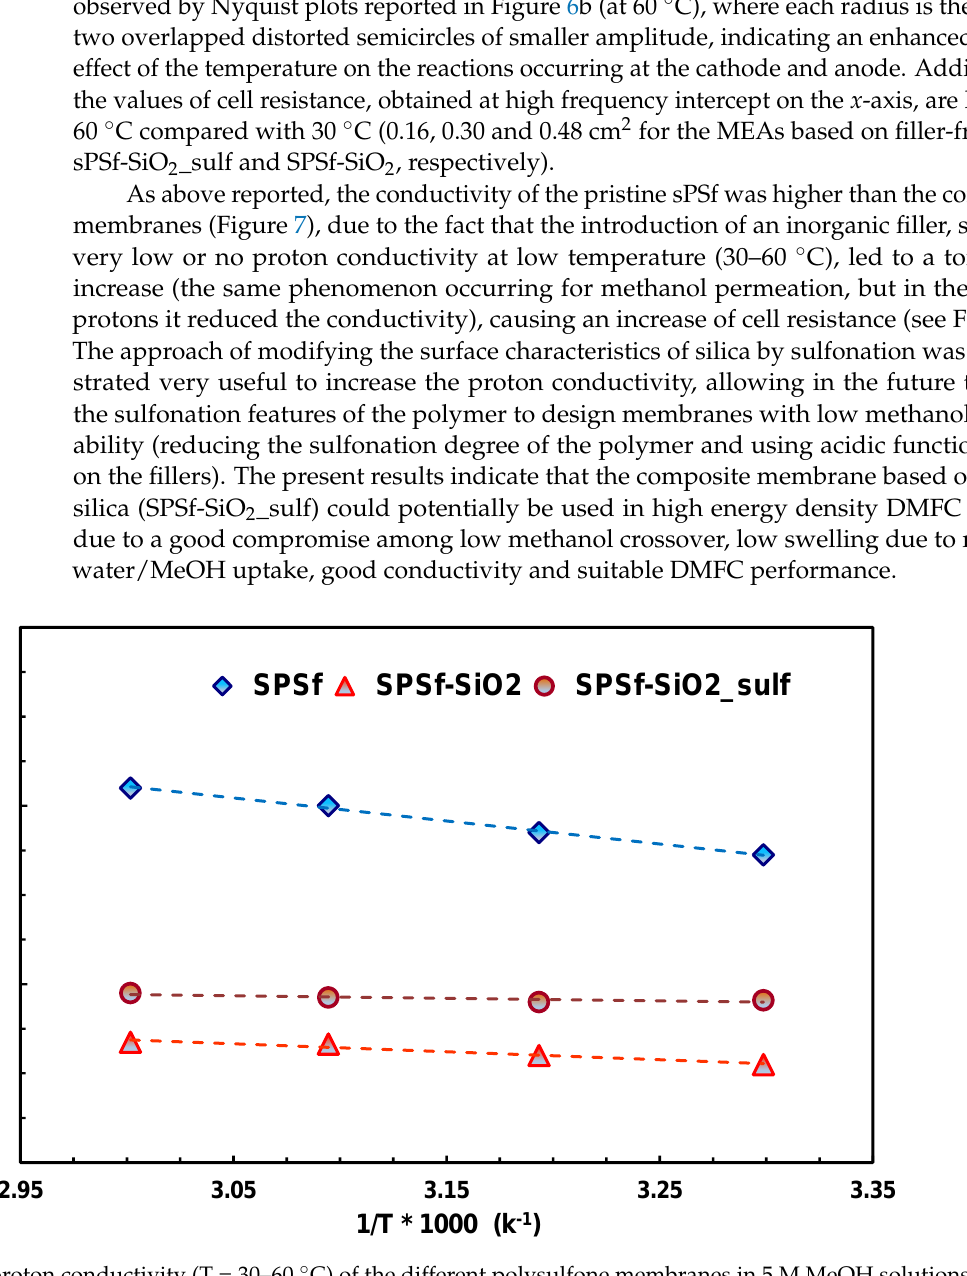
Figure 7. In-situ proton conductivity (T = 30–60 ◦ C) of the different polysulfone membranes in 5 M MeOH Figure 7. In- situ proton conductivity (T = 30 –60 °C) of the different polysulfone membranes in 5 M MeOH solutions.